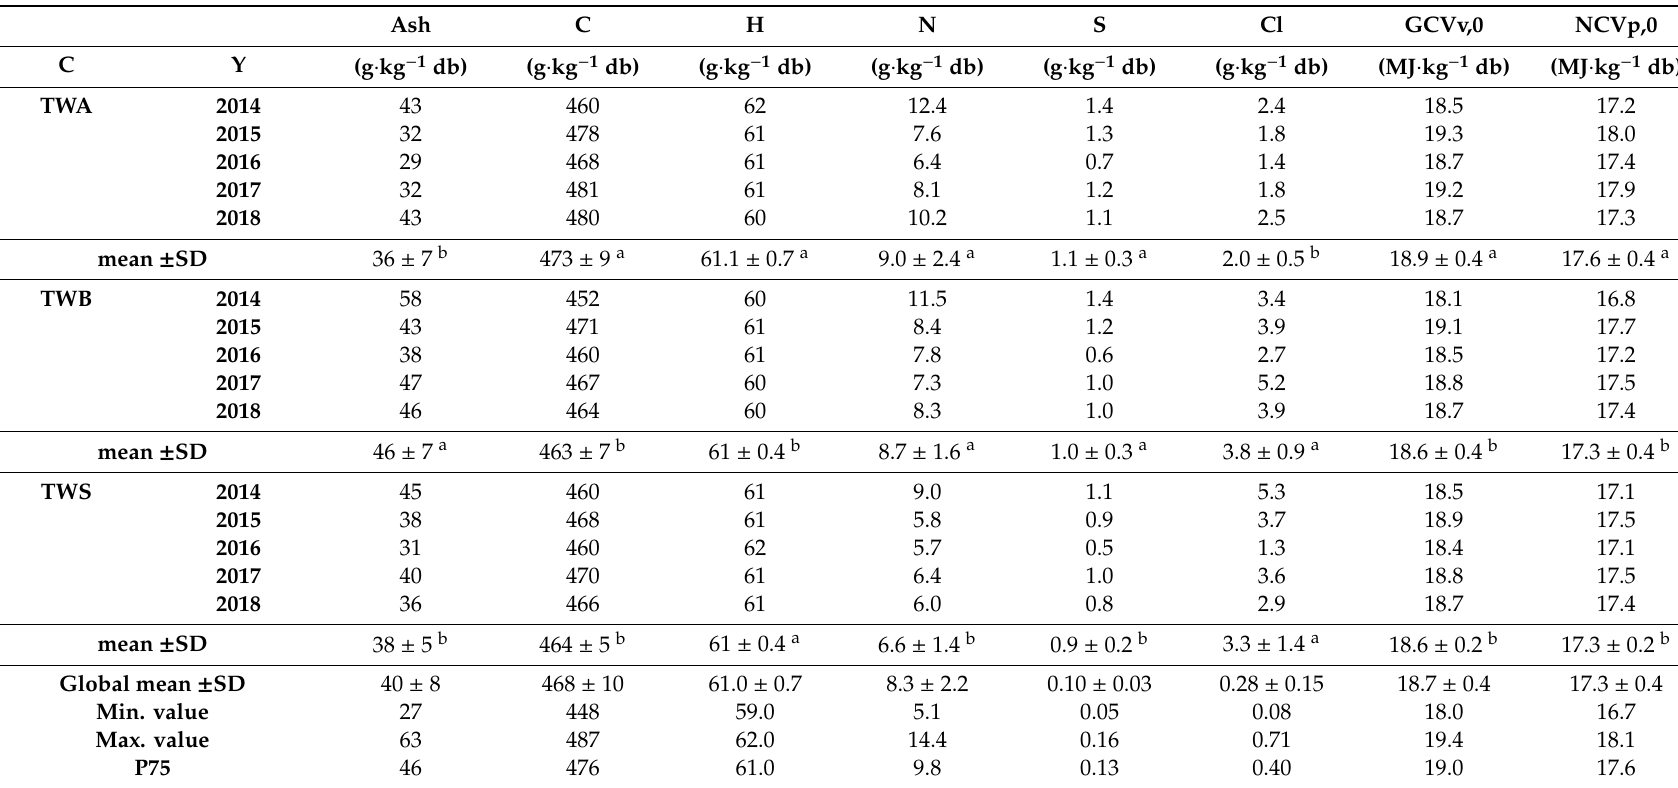
Table 8. Ash content, calorific values, and ultimate analysis of the tall wheatgrass cultivars collected at AL plots from 2014–2018. Mean values for three replicate plots per cultivar and